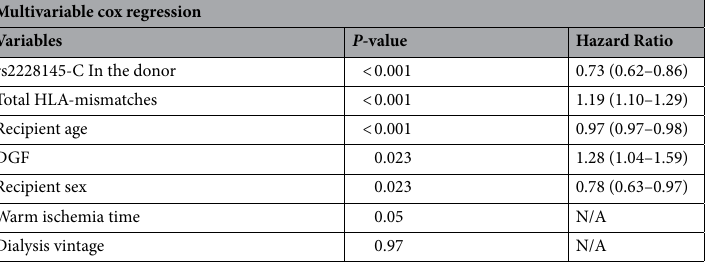
Table 3. Competitive analysis of the associations of clinical factors with rejection following kidney transplantation. Multivariable cox regression was performed with a stepwise forward selection. Only variables that with a P -value below 0.10 in the univariate analysis were included. Data are presented as hazard ratio with 95% confidence interval (CI) and P -value. In the final, the IL6R SNP (rs2228145-C, previously rs8192284) In the donor, total number of HLA-mismatches, recipient age, the occurrence of delayed graft function (DGF) and recipient sex (female compared to male) were included, whereas dialysis vintage and warm ischemia time were not.